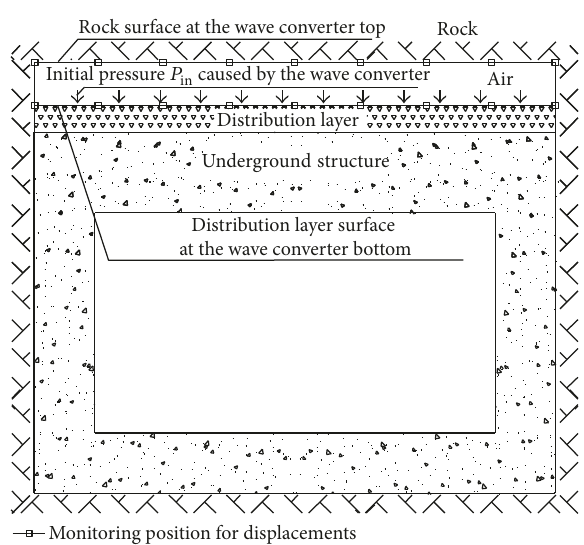
Figure 4: Schematic of model